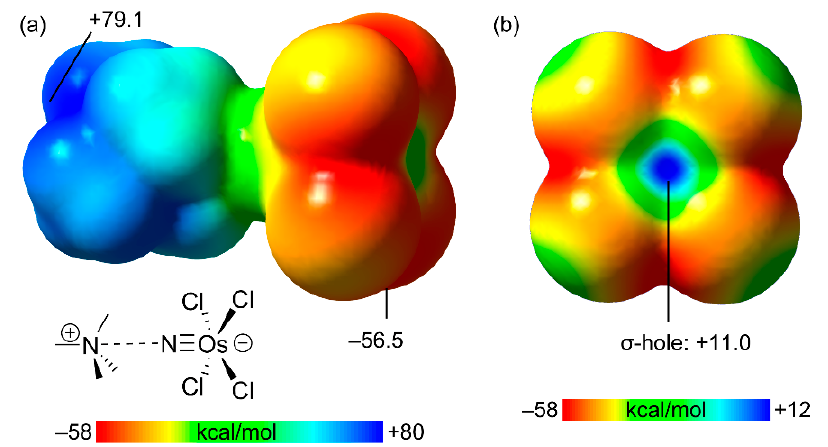
Figure 2. MEP surface of compound 1 using perspective ( a ) and “on-top” ( b ) representations. The MEP values at some points on the surfaces are given in kcal/mol. Level of theory: PBE0-D3/def2- TZVP. Isosurface: 0.002 a.u.